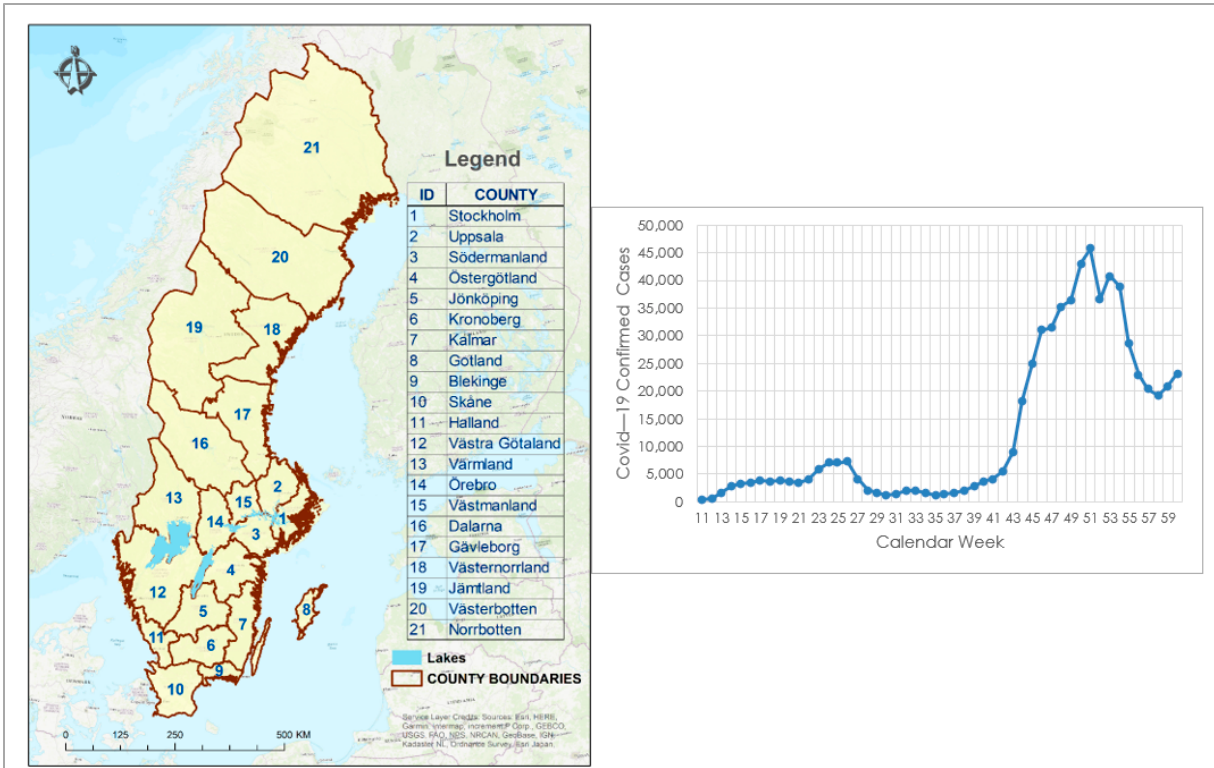
Figure 1. Sweden and its COVID-19 case profile through the seasons (2020).